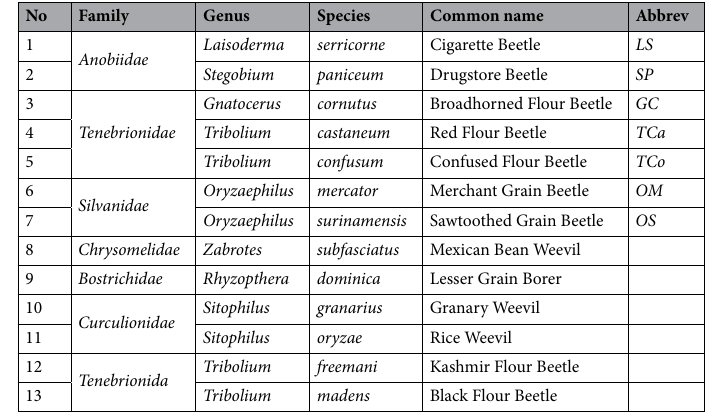
Table 1. The various species imaged in this study along with their genus , family and common names and the abbreviations used in this